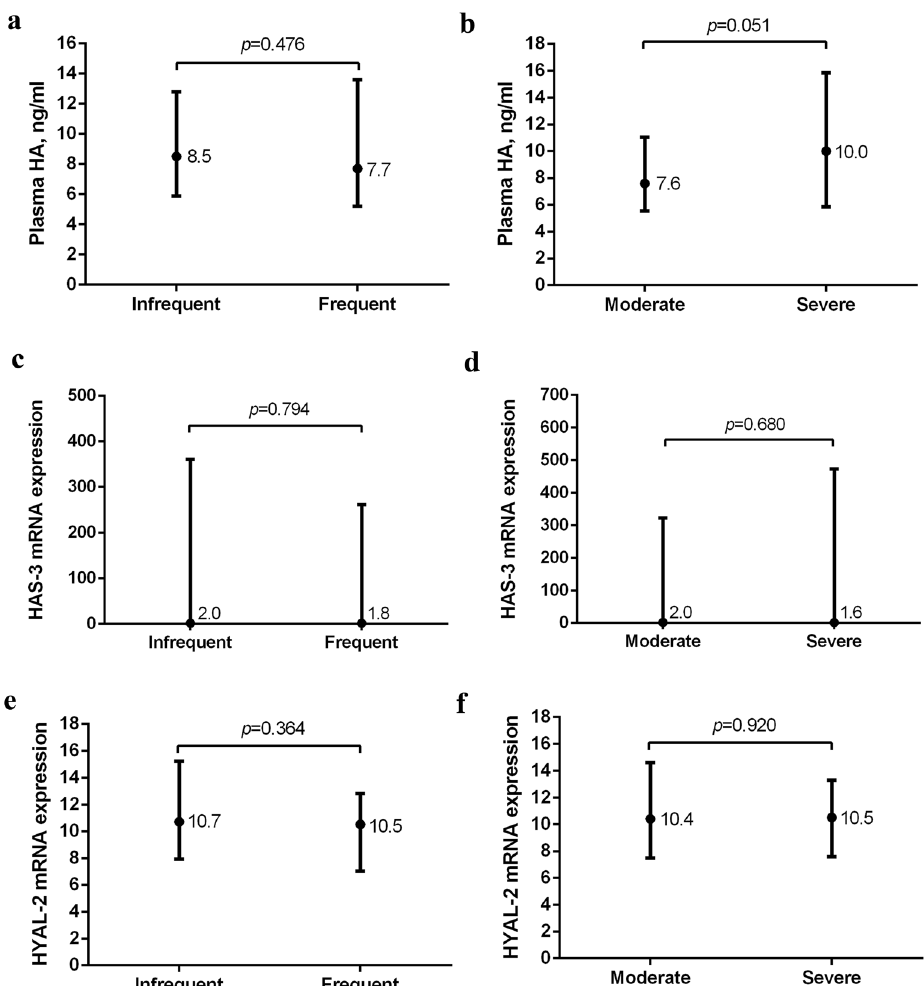
Figure 2. Differences in plasma HA and expression of HAS-3 and HYAL-2 in patients with COPD grouped by AECOPD frequency, and disease severity in the past year*. ( A ) Plasma HA in infrequent (n = 95) and frequent exacerbating patients (n = 86). ( B ) Plasma HA in patients with a moderate (n = 131) and severe disease history (n = 59). ( C ) Expression of HAS-3; and ( E ) expression of HYAL-2 in infrequent (n = 72) and frequent exacerbating patients (n = 64). ( D ) Expression of HAS-3; and F) expression of HYAL-2 in patients with a moderate (n = 100) and severe disease history (n = 41). *Infrequent AECOPD were defined by < 2 AECOPD and frequent AECOPD by ≥ 2 AECOPD in the past year. A moderate disease history was defined by no airway- related hospitalizations and a severe disease history by ≥ 1 airway-related hospitalization in the past year. Median concentrations/expression levels and interquartile ranges are presented. Figures were created using GraphPad Prism 8.3.5, https:// www. graph pad. com/ scien tific- softw are/